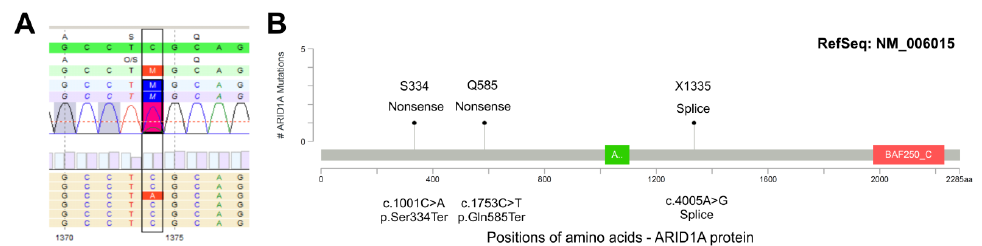
Figure 4. ARID1A mutations in sq-BLCA. ( A ) Exemplary illustration of a nonsense ARID1A mutation with an allele frequency of 20% (c.1001C > T, p.Ser334Ter, estimated tumor cell content 40%). ( B )